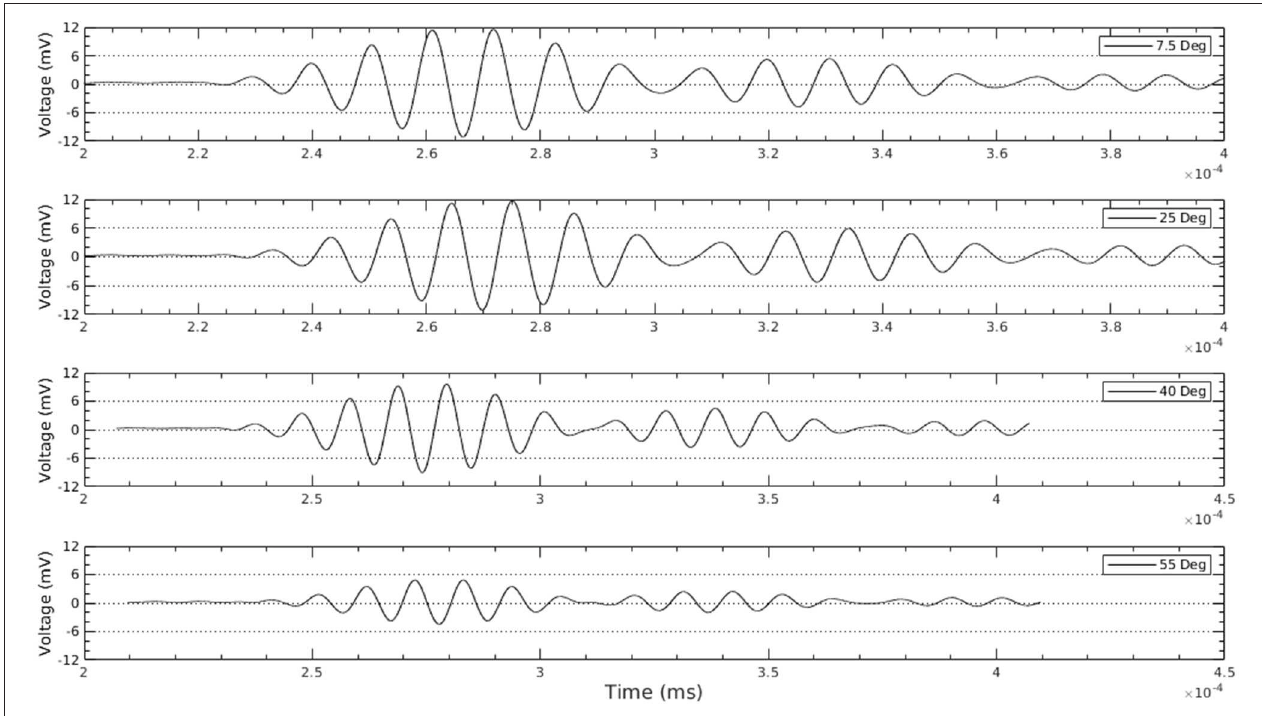
FIGURE 4 | Representative series of reflected acoustic waveforms ranging from angles 7.5 ◦ to 60 ◦ . The series shown is for fresh snow sample FSC.